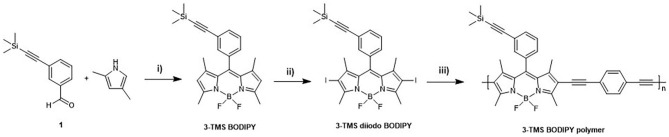
Synthesis of 3-TMS polymer. Reagents and conditions: i) TFA, DDQ, BF3OEt2, TEA, dry CH2Cl2, N2, RT, 3 days; ii) I2, HIO3, EtOH, r.t. overnight; iii) Pd(PPh3)2Cl2, PPh3, CuI, THF/Diisopropylamine, reflux, 3 days.